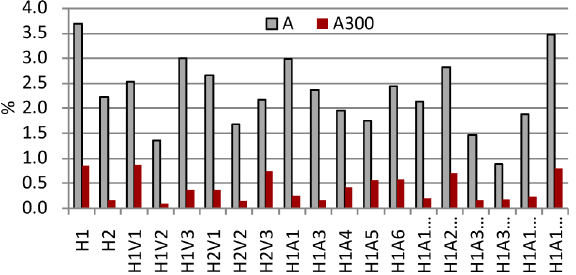
SF T 500 mm sec.